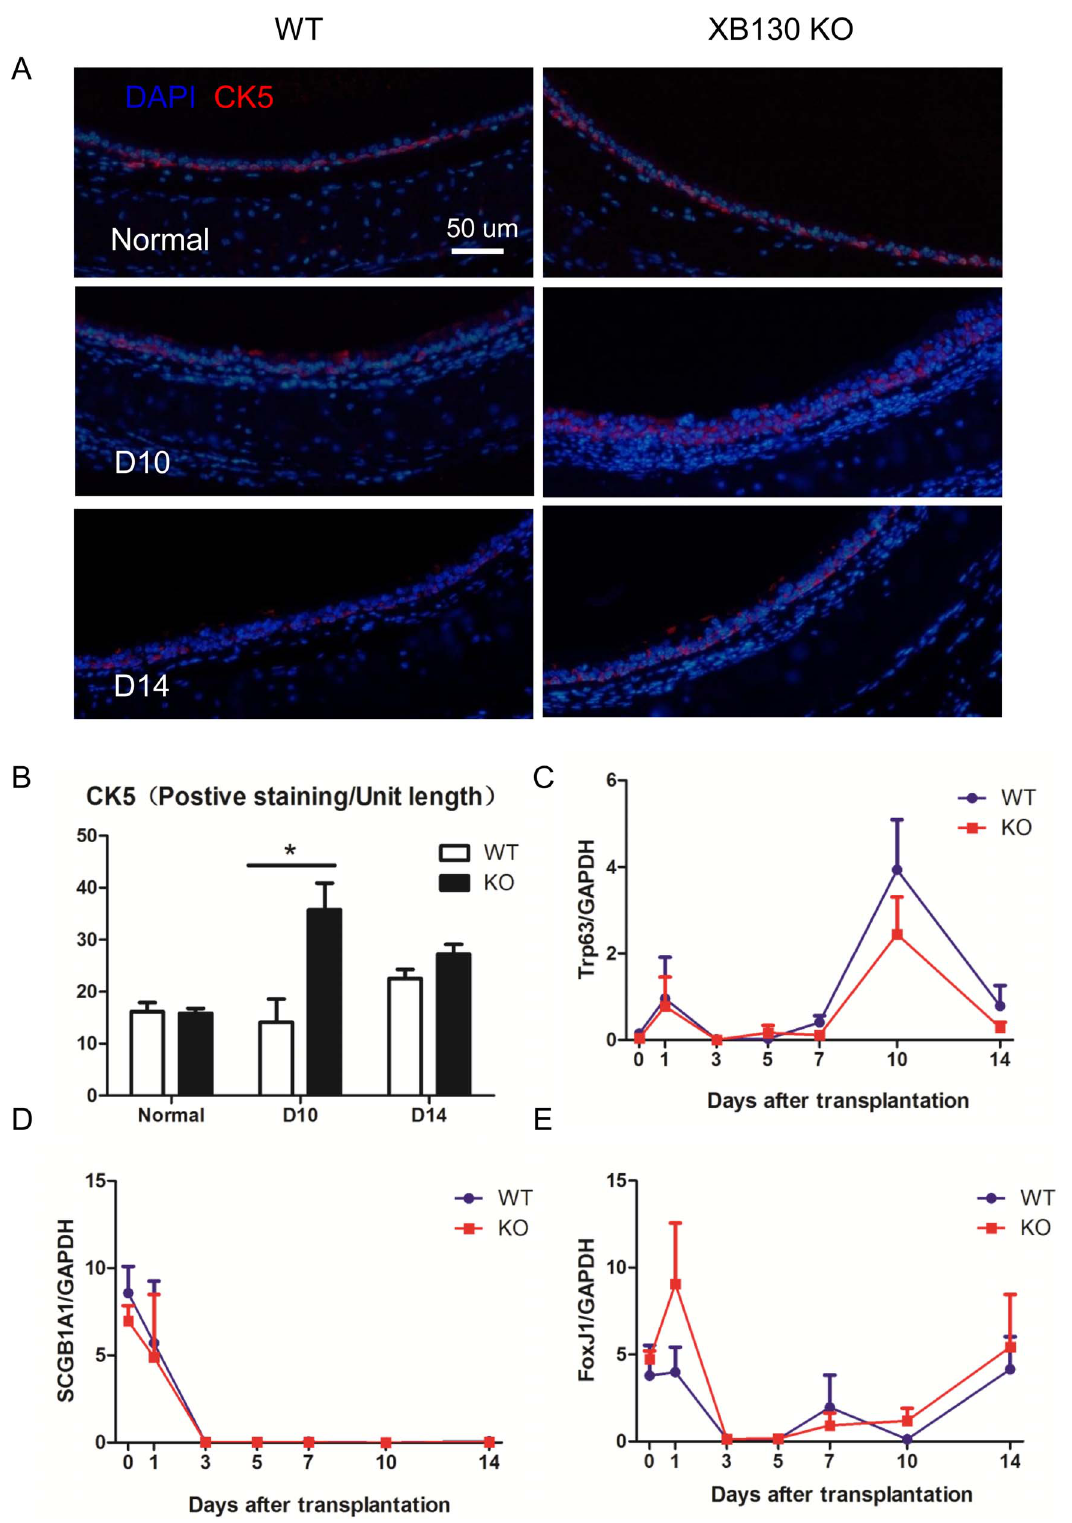
Figure 6. Increased CK5 + airway basal cells are noted at Day 10 after tracheal transplantation. Basal cells were determined by immunofluorescent staining for Cytokeratin 5 (CK5). More CK5 + cells were found in the KO group at D10 after transplantation (A and B). The mRNA levels of Trp63 (C, basal cell marker), Scgb1A1 (D, Clara cell marker) and FoxJ1 (E, ciliated cell marker) were examined with RT-PCR. Dynamic changes of mRNA levels were noted during airway injury and repair. However, there was no difference between WT and KO groups.